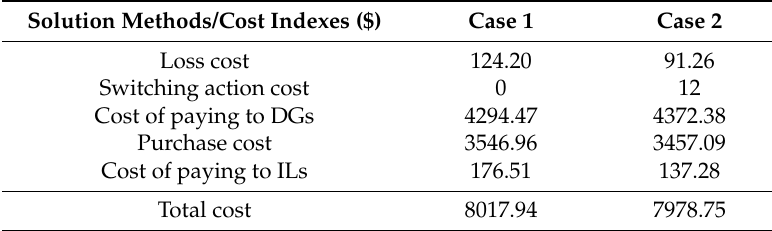
Table 3. Cost comparisons between case 1 and case